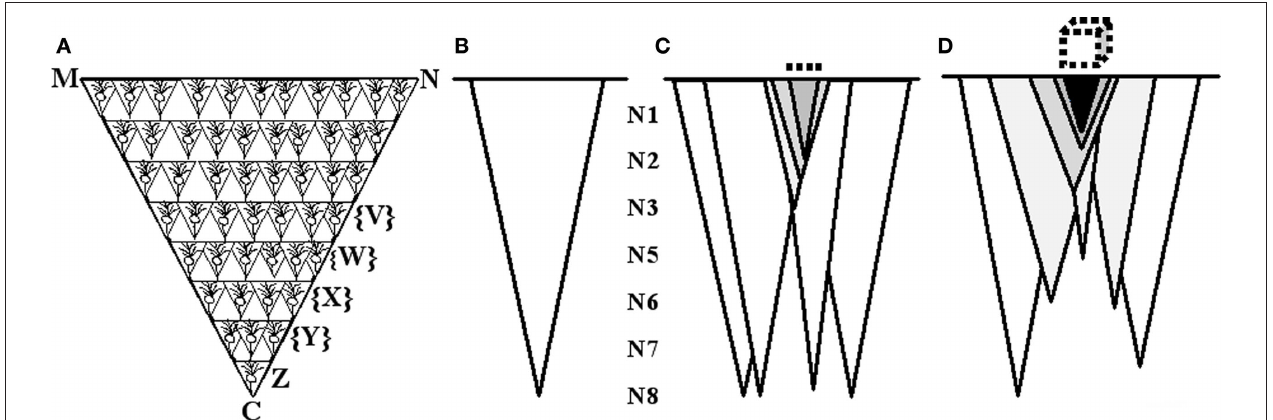
FIgure 4 | Schematic representation of the formation of net semblance from synaptic and network semblances. (A) Cartoon showing the formation of semblance at one of the presynapses C of the neuron Z when its corresponding postsynapse D (see Figure 2 ) is activated through the functional LINK. The semblance of activity at the presynaptic terminal C indicate that the activity could be arriving from the neuron Z which in turn could be receiving activation from a set of neurons {Y}. In this manner, we can extrapolate the location of neurons of the penultimate orders in a retrograde fashion until we reach the sensory receptors. The final sensory receptor group is represented by the line MN which represents the identity of the sensation. From the sensory stimulation point of view, this reflects the fact that stimulation of the sensory receptors on the line MN can activate the presynaptic terminal C. (B) A is summarized and drawn as an isosceles triangle and it represents the